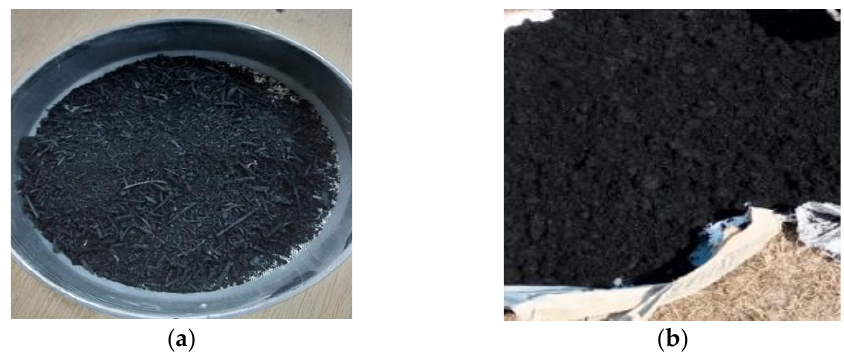
Figure 3. Waste materials used in this study. ( a ) Crumb Rubber (CR). ( b ) Sugarcane bagasse Ash. Table 3. Chemical composition of crumb rubber [59].